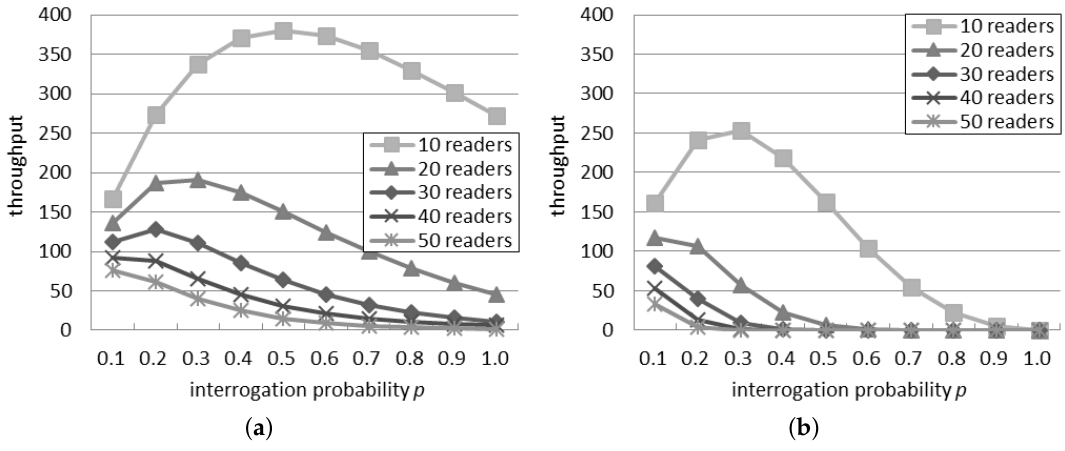
Figure 2. Throughput in the probabilistic interrogation scenario. ( a ) Single interference model; ( b ) Additive interference model.